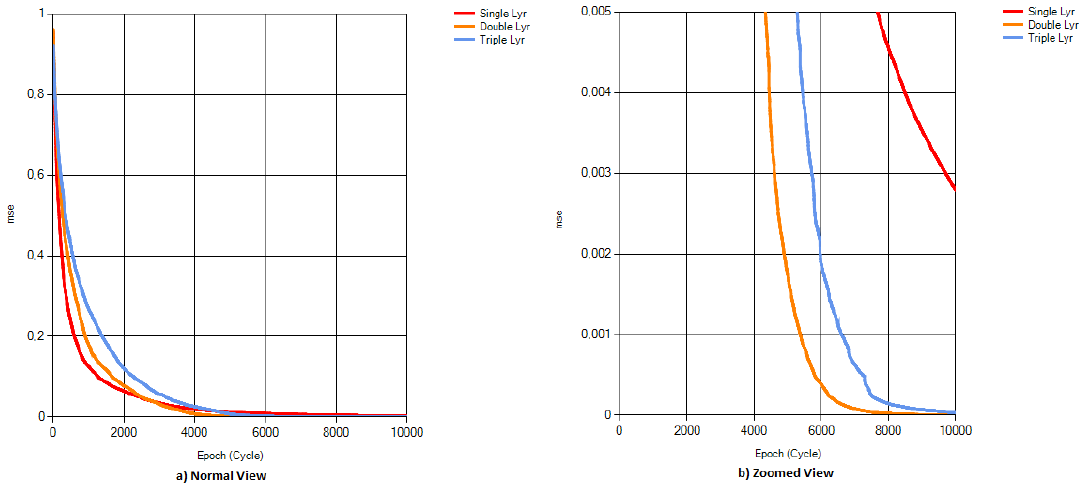
Figure 7. Effect of hidden layer number on mse in the ABC-based ANN model. Table 5. Different attempts to obtain better results in